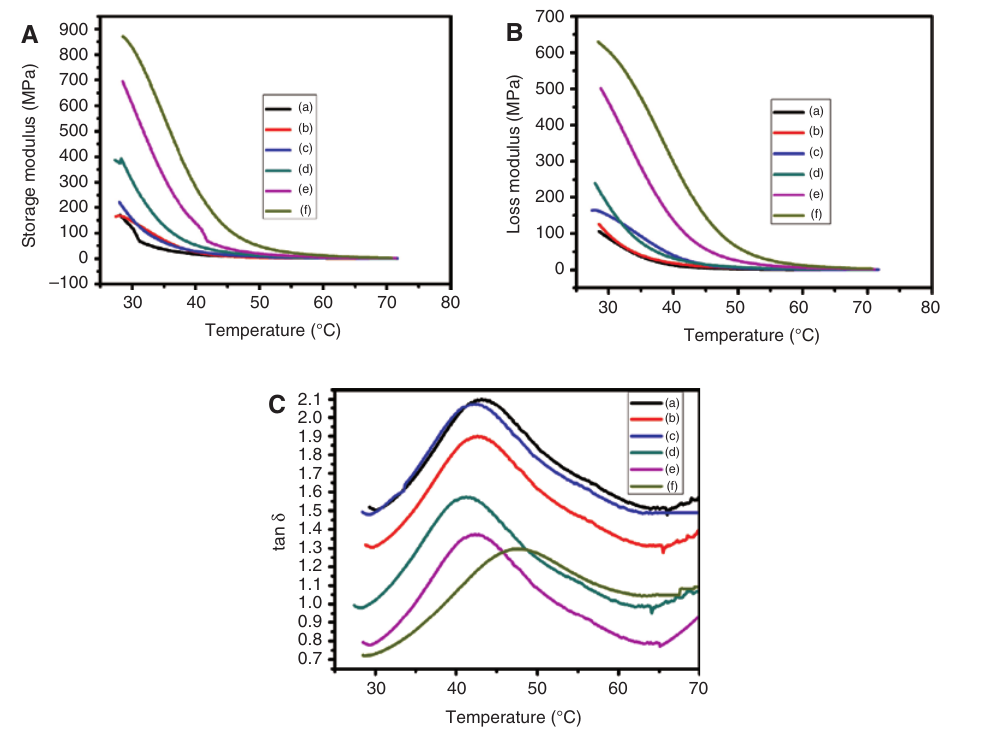
O nanoparticle 2 3 O 2 3